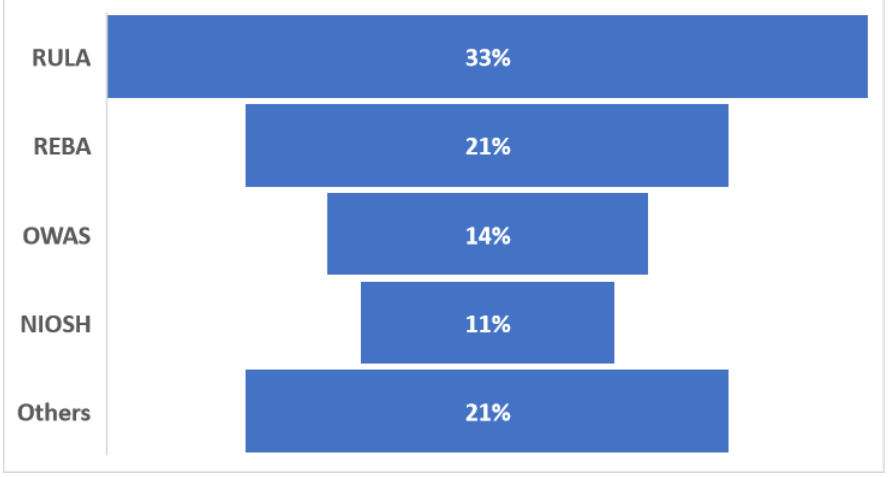
Figure 9. Comparison of used ergonomic methods percentage. Source: own processing.